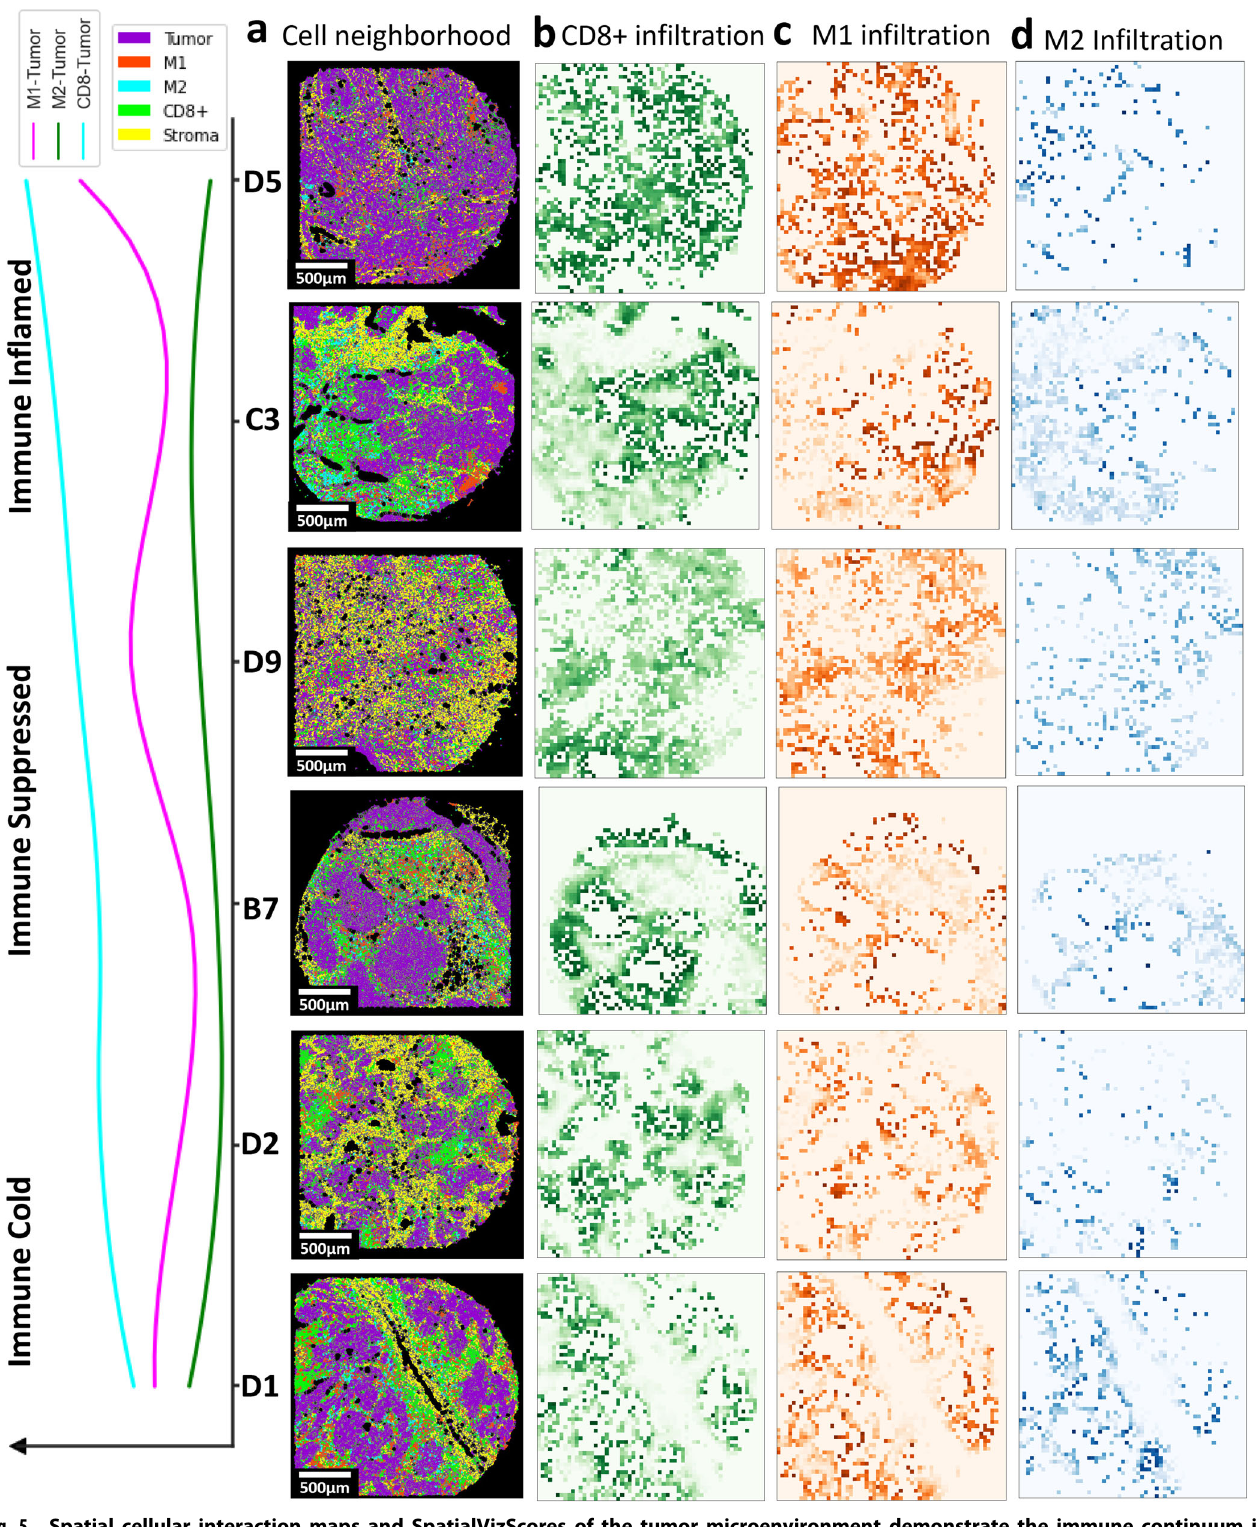
Fig. 5 Spatial cellular interaction maps and SpatialVizScores of the tumor microenvironment demonstrate the immune continuum in lung cancer tissues. a Cell network and spatial proximity maps on lung cancer samples provided the interaction of tumor/T (in magenta), stroma/S (in yellow), CD8 α (in green), M1 (red), and M2 (cyan). b Spatial interaction map demonstrated the distribution of tumor CD8 α cells. It follows a continuum where it ’ s highest for immune in fl amed and immune suppressed tumors but damps down for immune cold tumors. This is further validated by the line graph showing the distribution of the interaction among tumor regions, CD8 α , M1, and M2 ranked by CD8 α - Tumor score. c Spatial interaction map indicated the distribution of tumor and M1 cells. It follows a continuum where it ’ s highest for immune in fl amed tumors, but damps down for immune suppressed tumors, and tapers off for immune cold tumors. d Spatial interaction map provided the distribution of tumor and M2 cells. It follows a continuum where it was the highest for immune suppressed tumors, but decreased for immune in fl amed tumors, and tapered off for immune cold